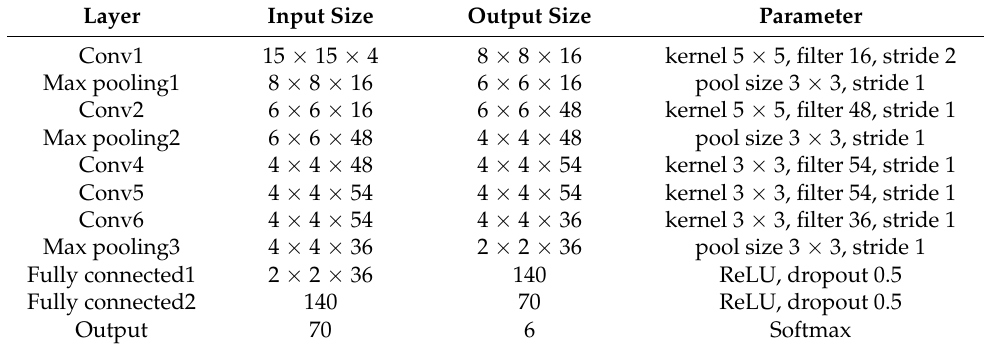
Table 3. Modified AlexNet model structure. ReLU, rectified linear